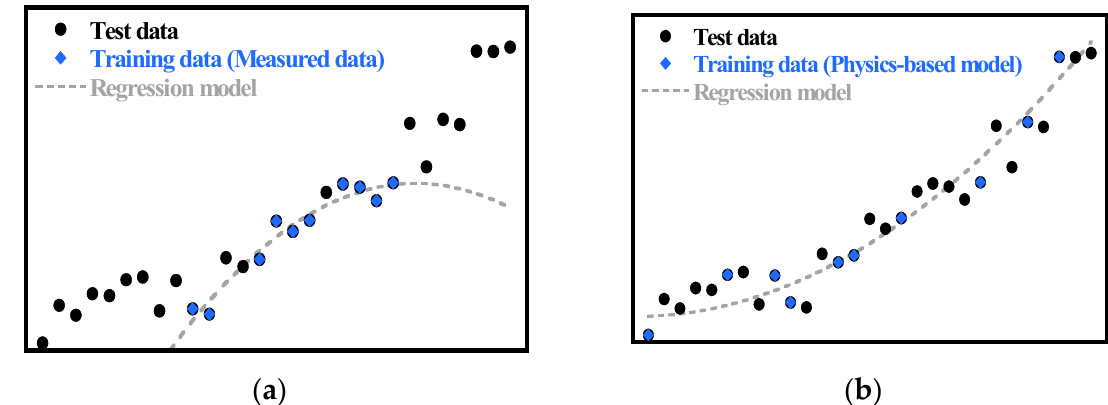
Figure 1. Illustration of the comparison between regression models trained by measured data and a physics-based model: ( a ) Regression model trained by measured data; ( b ) Regression model trained by a physics-based model.